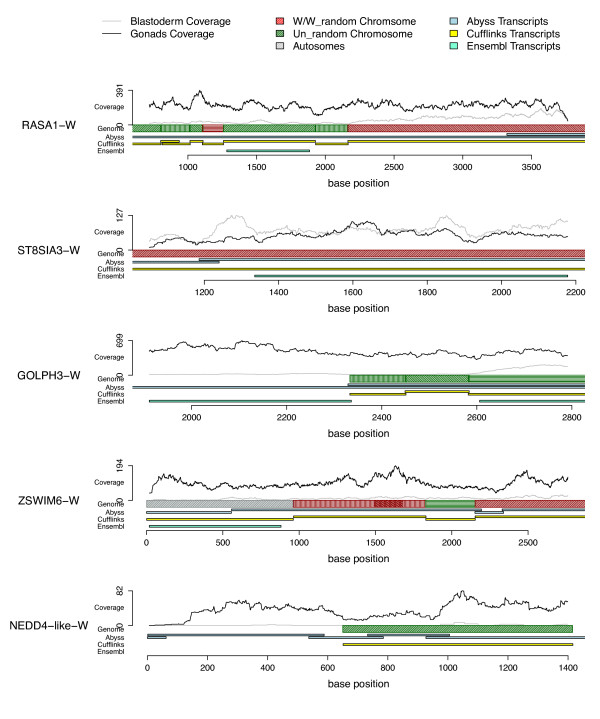
Delineation of complete W-linked transcript sequence. Complete transcript sequences for all W-expressed genes were determined using a combined approach of assembling transcripts from Cufflinks, the Abyss de-novo assembly and the latest chicken annotation data (Ensembl). An example of the open reading frame for five W-linked genes is shown. The hatched rectangles represent the different genomic regions to which sequences could be aligned: the W/W_random chromosome (red), Un_random chromosome (green), autosomes (grey) and gaps represent absent genomic sequence. The coloured bars below show the corresponding transcripts defined by Ensembl (aqua), Cufflinks (yellow) and ABySS (blue) analyses. The plots along the top represent the read coverage for the female gonadal sample (black) and the blastoderm sample (grey).